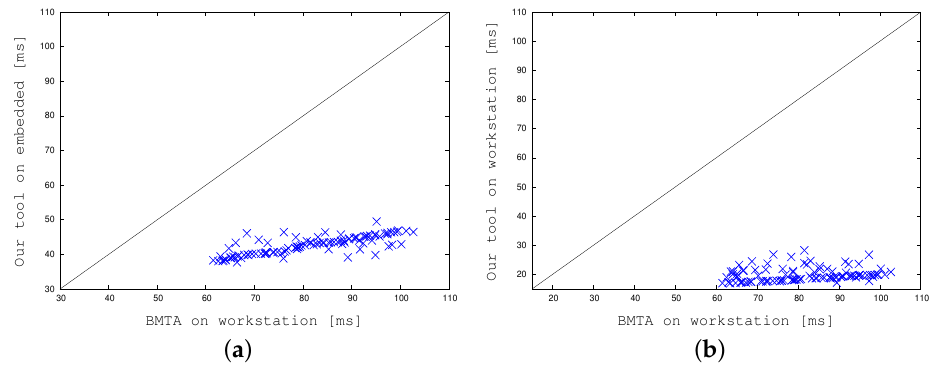
Figure 20. Comparing computation times: BMTA running on a desktop workstation versus our divide-and-conquer concurrent approach running on the embedded system ( a ), and the desktop workstation ( b